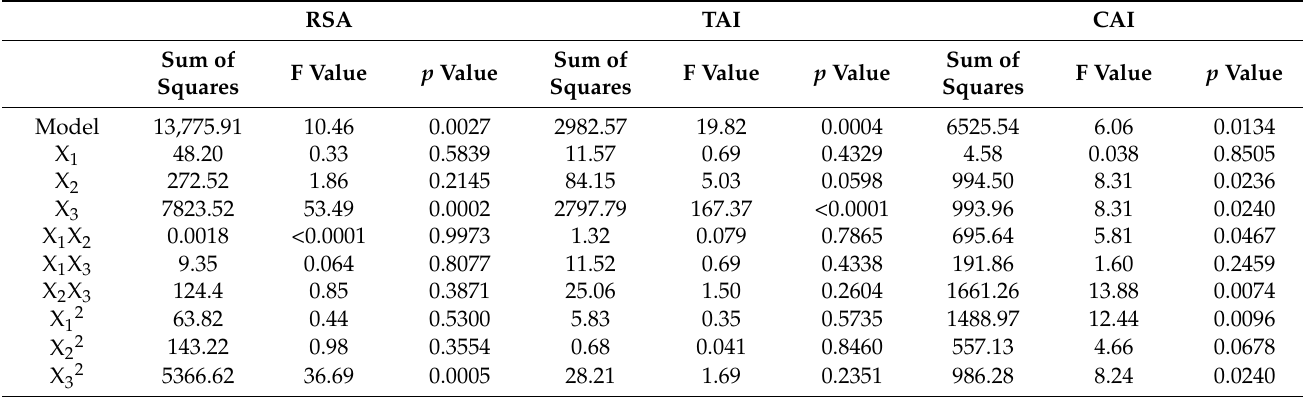
Table 4. ANOVA of the experimental results of CCD for full quadratic